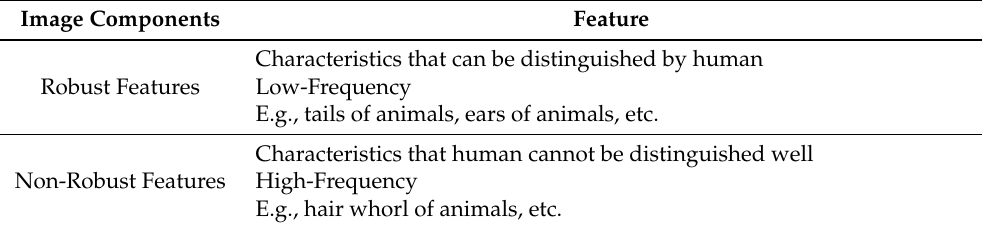
Table 1. Image components. Image Components Robust